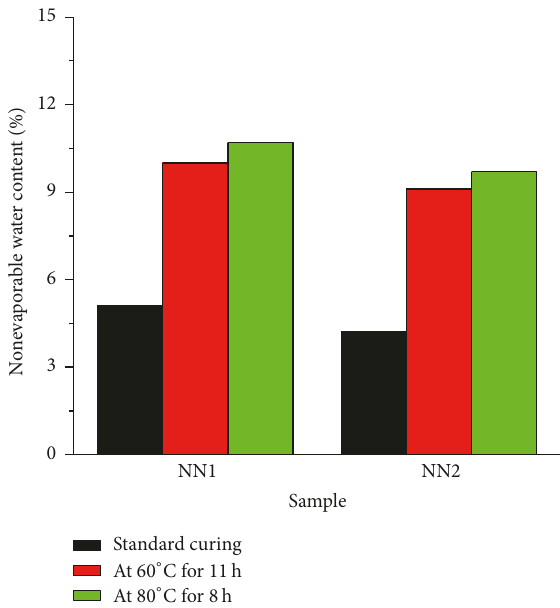
Figure 11: Nonevaporable water contents of the pastes containing phosphorus slag with W/B of 0.32 at the age of 90